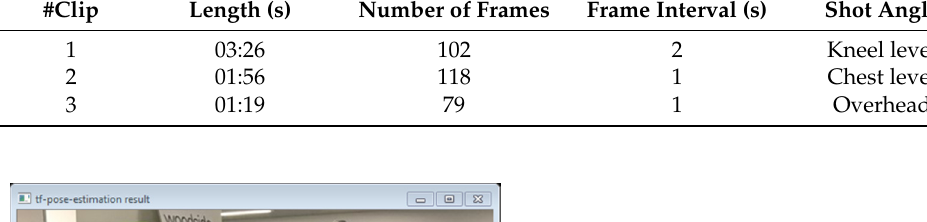
Table 3. Details of video clips for validation.